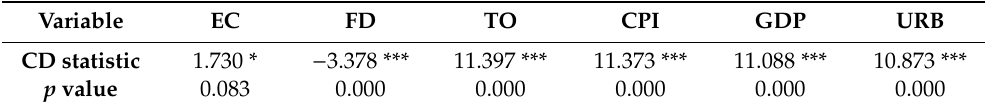
Table 1. Pesaran [36] test for cross-sectional dependence.